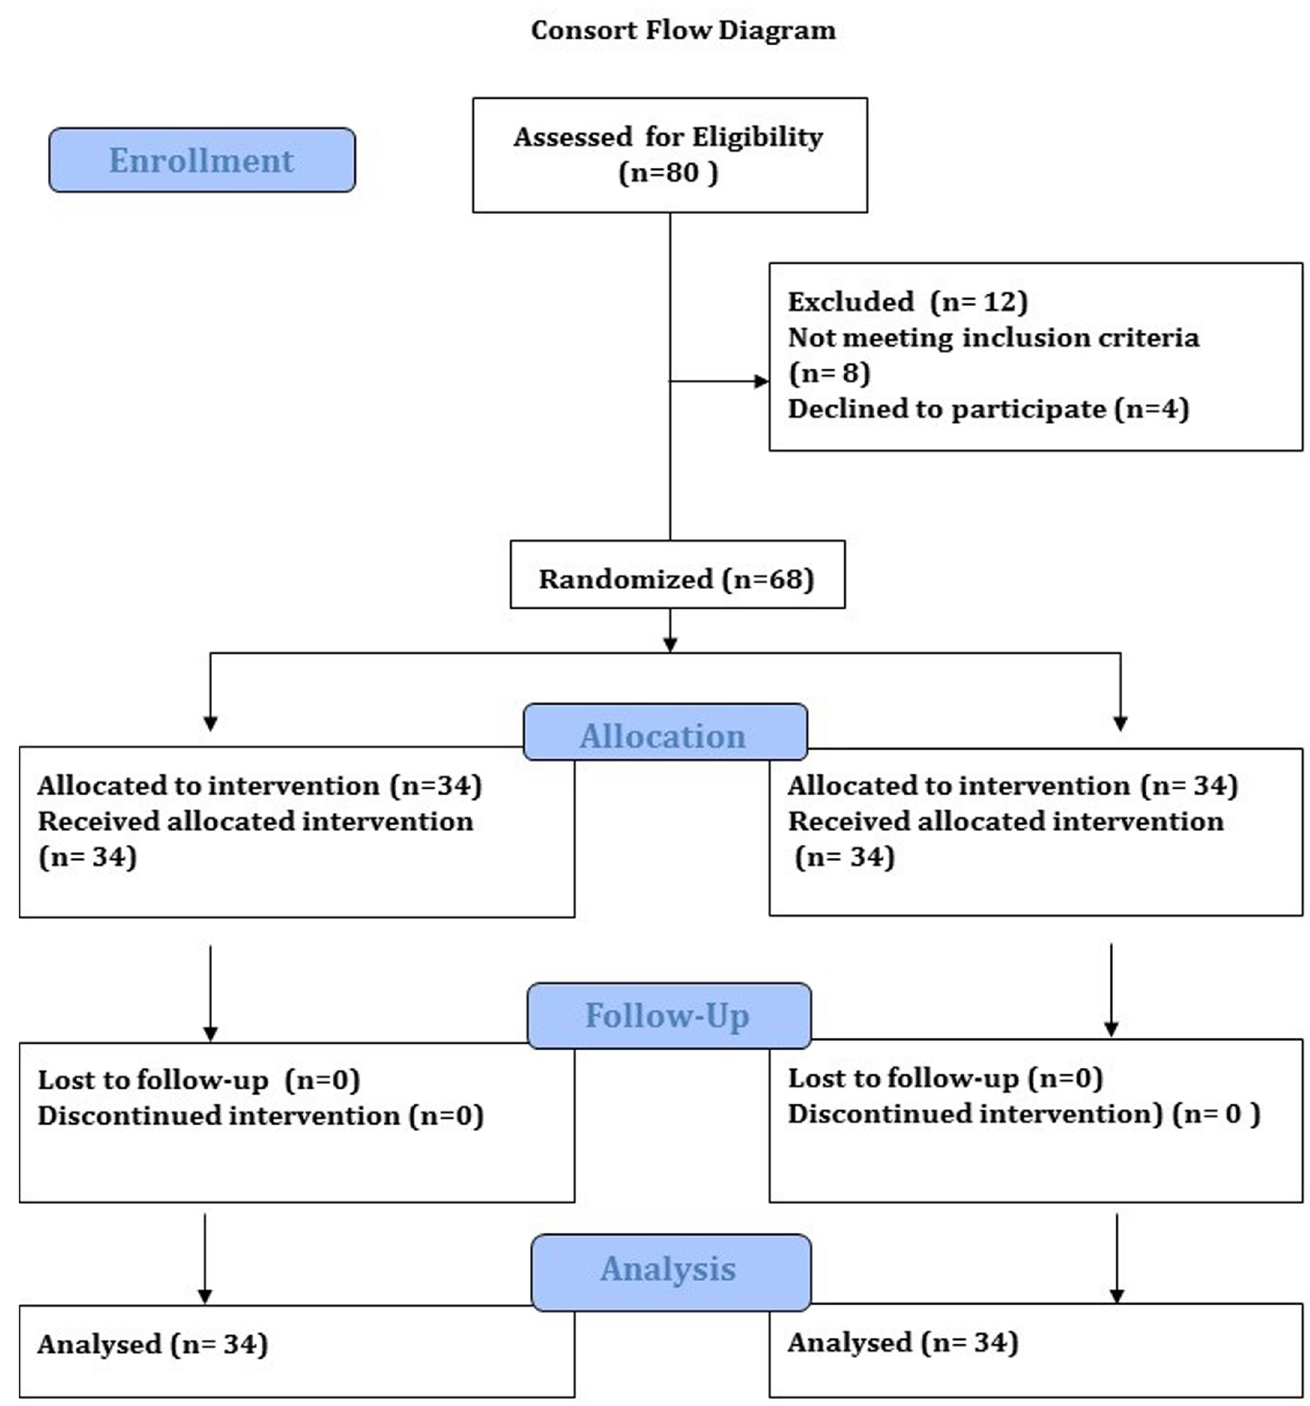
Fig 1. CONSORT flow